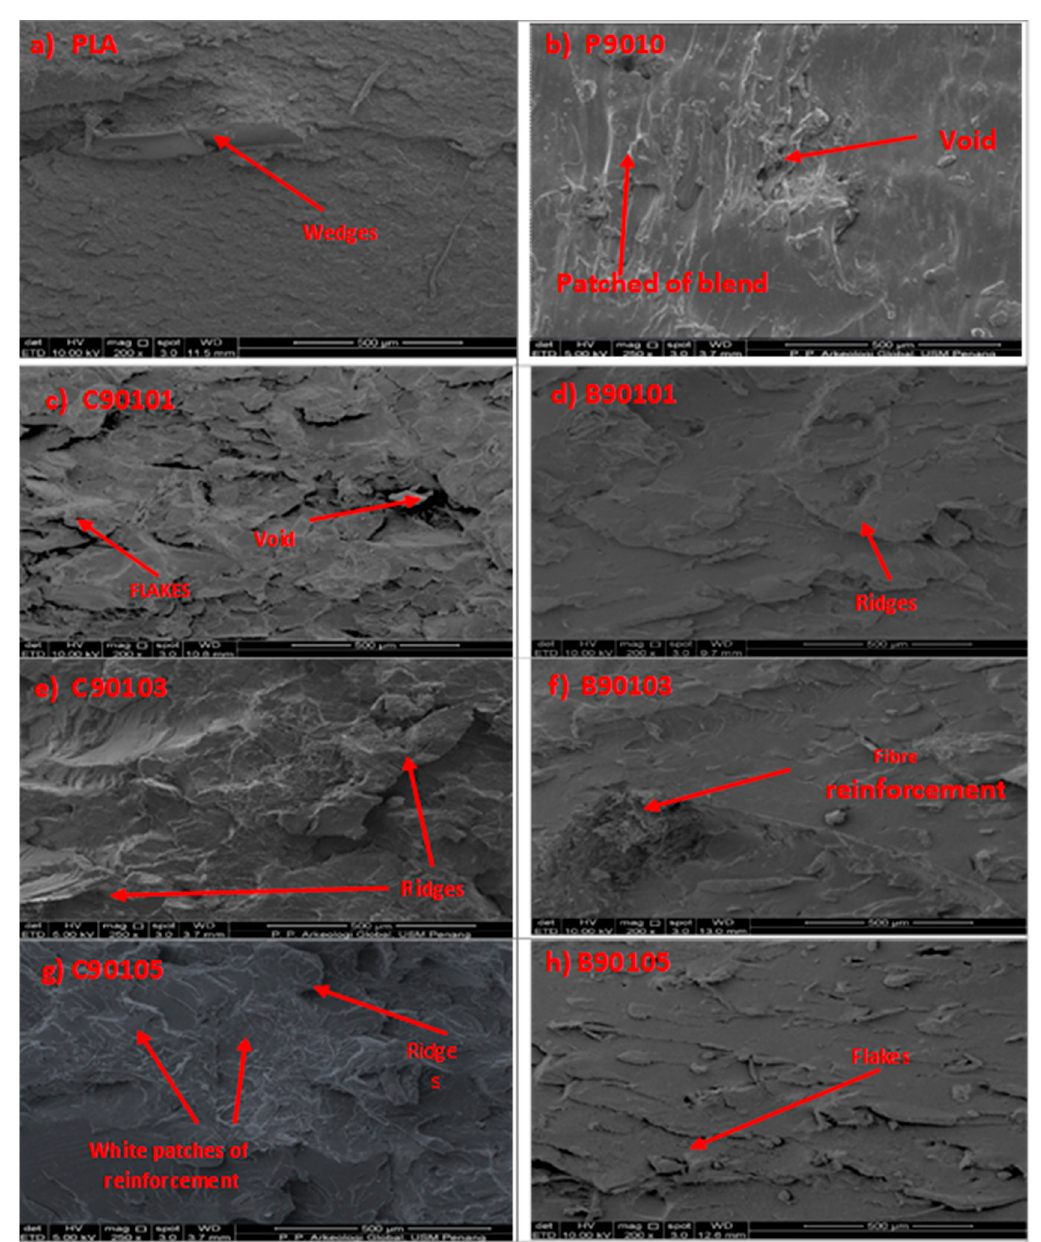
Figure 5. Comparative analysis of the morphological properties of bamboo and commercial CNF ‐ reinforced biocomposites.